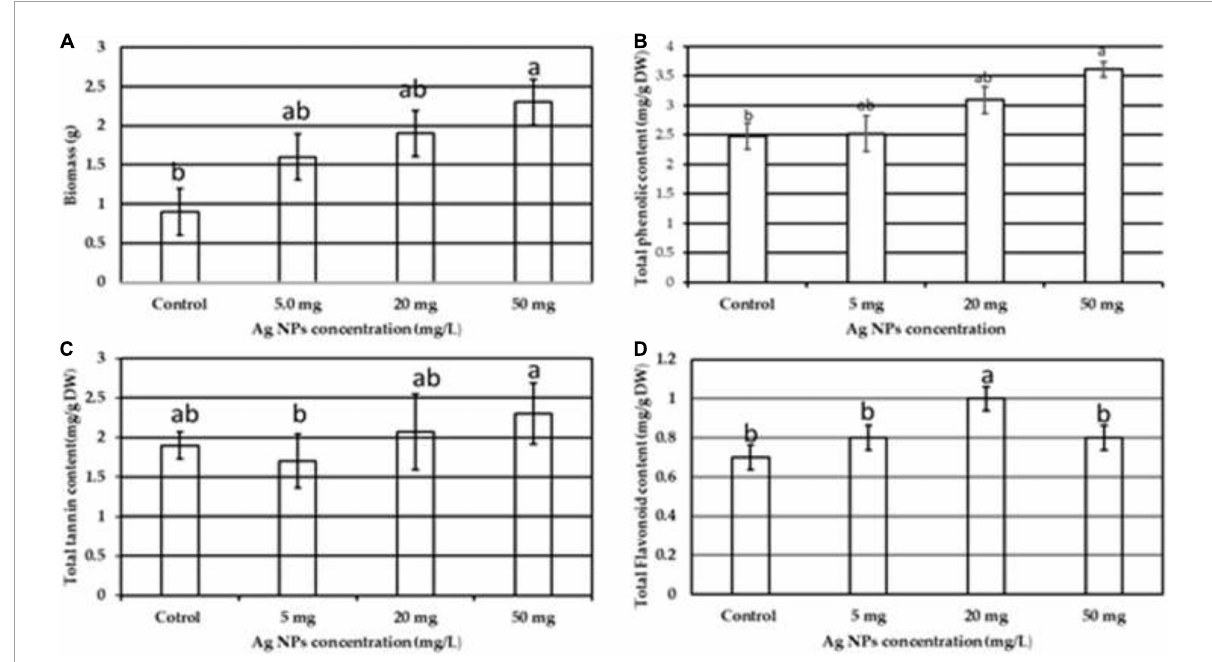
FIGURE5 The impact of different doses of biogenic AgNPs on the callus of J. procera (A) biomass, (B) TPC, (C) TTC, and (D) TFC. a , b , c Means within the same column with different superscripts differ significantly ( P < 0.05).